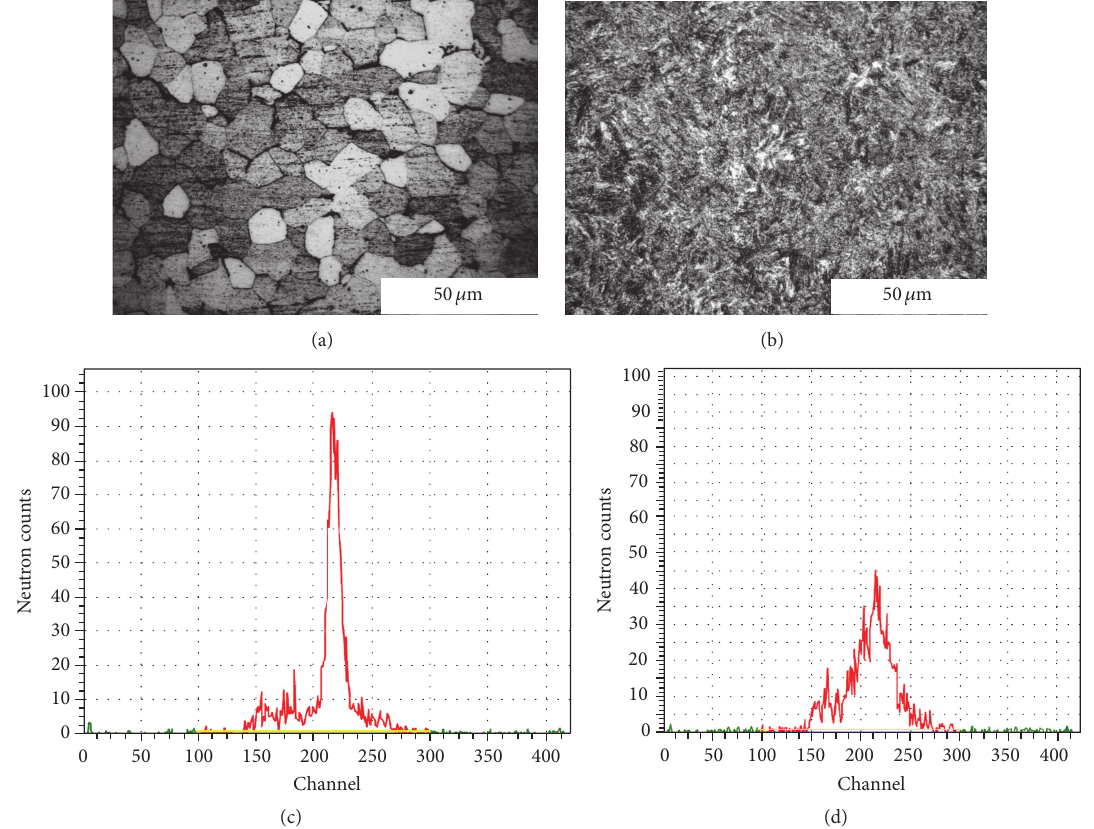
Figure 10: Microstructure of (a) sheet material showing ferritic structure adapted from [29] and (b) rivet material showing martensitic structure adapted from [29] and profile of neutron counts showing shift and peak broadening due to different microstructure in (c) sheet material and (d) rivet.